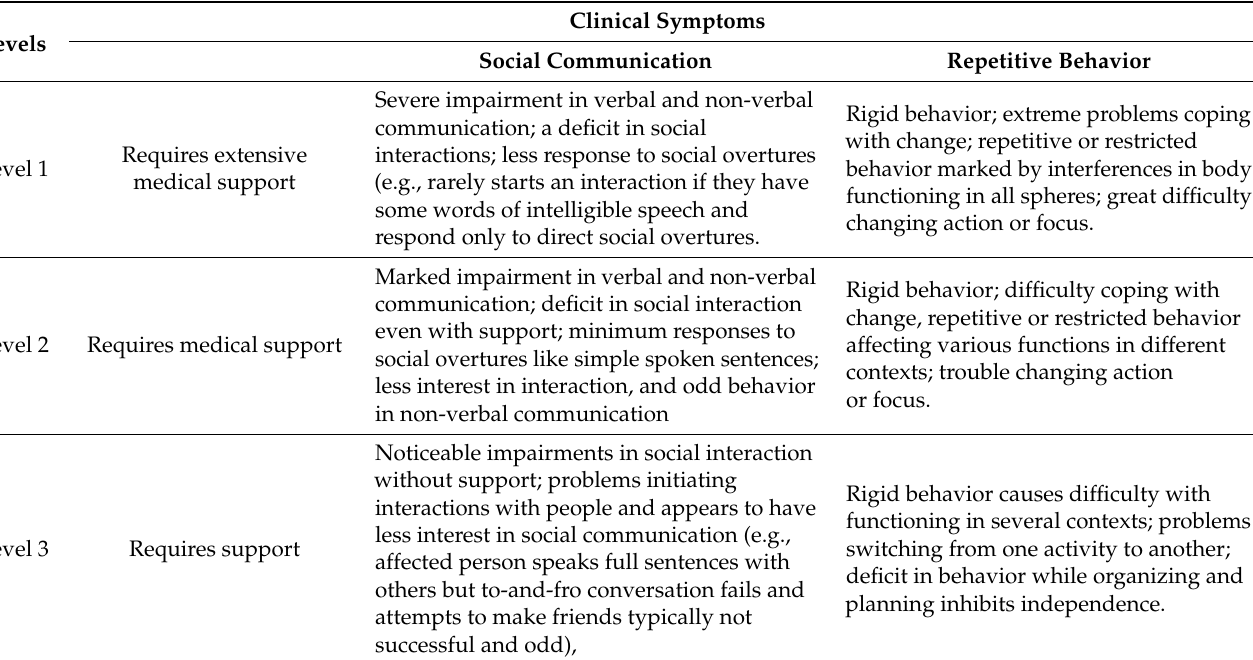
Table 1. Three severity levels of ASD (modified from American Psychiatric Association, 2013) [13].